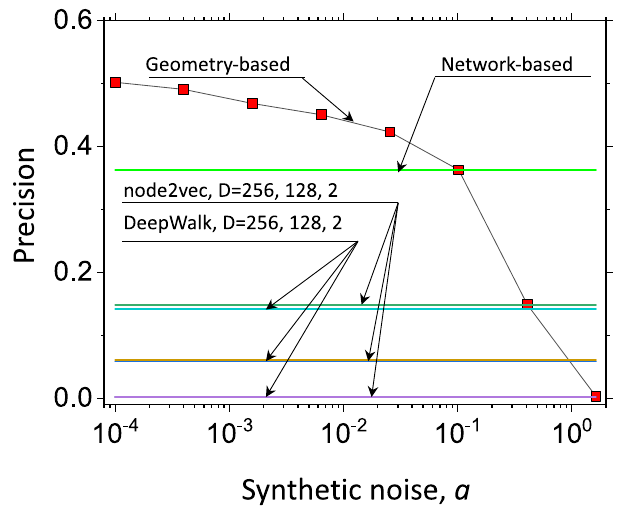
Fig. 6 | Noise tolerance and comparison to other embedding methods. We analyzethe toleranceof distanceto geodesicto node coordinate uncertancies.We consider the hyperbolic map of the incomplete network of the Internet at the Austonomous System (AS) level at the q =0.5 missing link rate. We plot the preci- sion of distance to geodesic in fi nding nearly shortest path nodes as a function of synthetic noise magnitude a , which we add to learned node coordinates: ^ θ ^ r i = θ i + a 2 π X i , i = r i + aRY i , { X i , Y i } ← U (0,1).We compare the precision of distance to geodesic to the network-based method and two popular Euclidean embedding algorithms node2vec 36 and DeepWalk 37 of different dimensionality D . Each simu- lation is the average over 1000 randomly chosen node pairs. In cases of node2vec andDeepWalk,weranknodesbasedontheirdistanceto Euclidean geodesicdrawn between the path endpoints. For each Euclidean embedding algorithm, the preci- sion increases as a dimensionality D increases. Note that both node2vec and DeepWalk are less accurate than the network-based